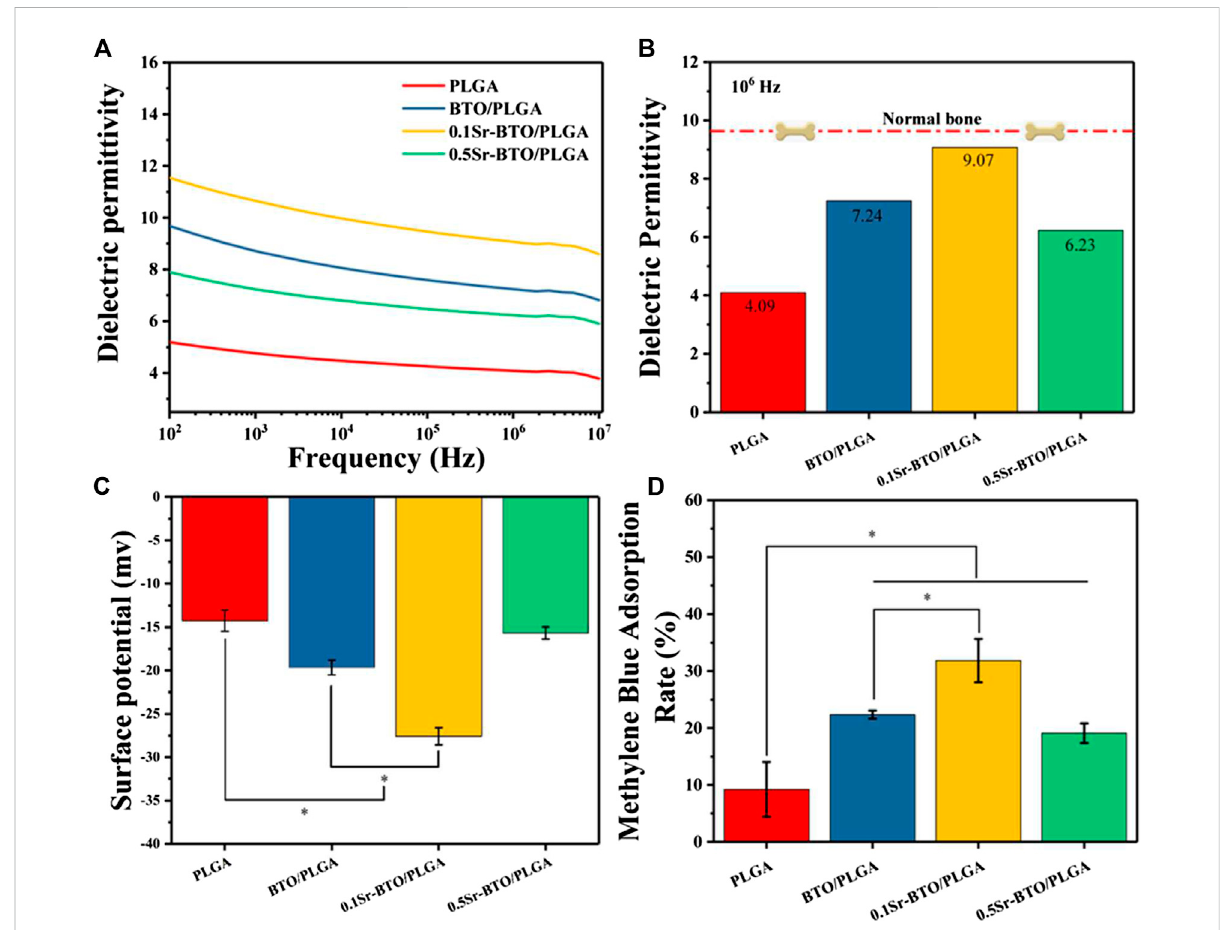
FIGURE 3 (A) DielectricpermittivityofSr-BTO/PLGA. (B) Dielectricpermittivityat10 6 HzoftheSr-BTO/PLGAwascomparedwiththatofnormalbone(red line) (C) Zeta potential of Sr-BTO/PLGA microspheres at room temperature. (D) Adsorption rate of Sr-BTO/PLGA microspheres for methylene (MB) blue